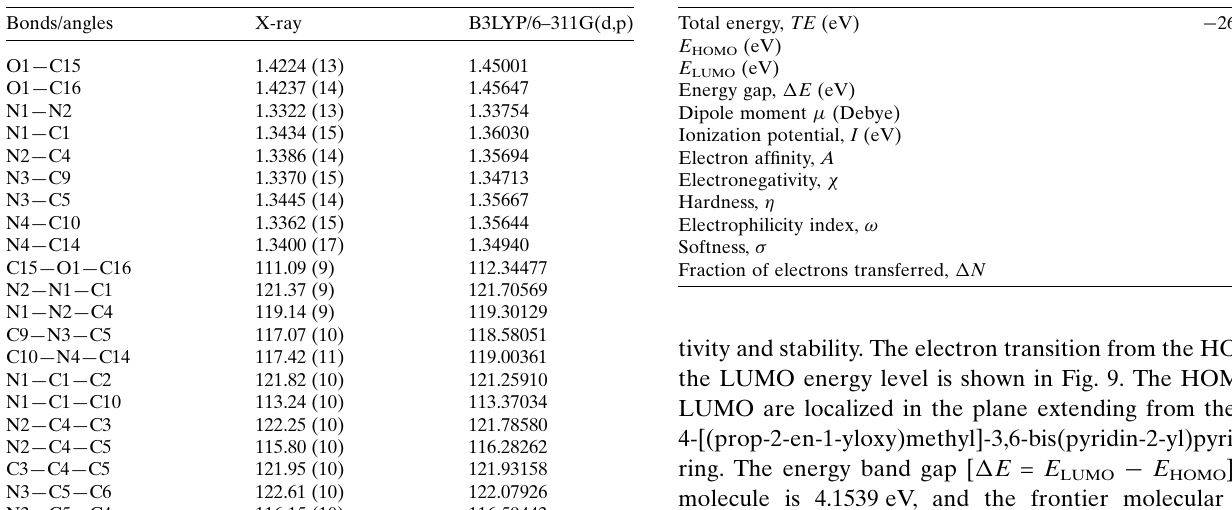
Table 4 Calculated energies for the title compound.